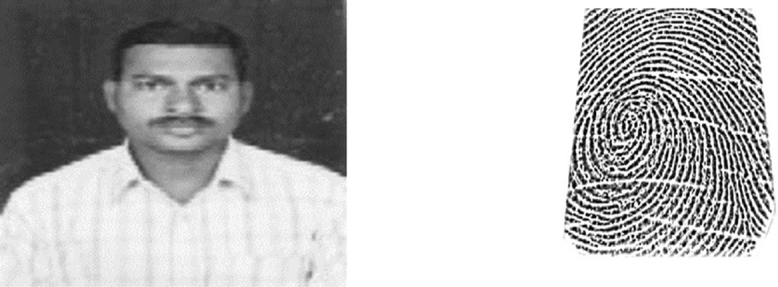
Result of filter.